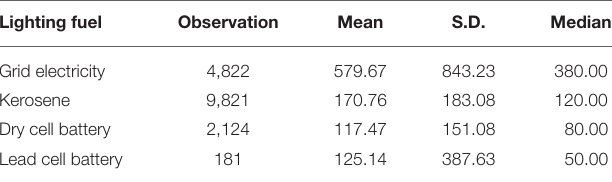
TABLE 3 | Average marginal effects of household lighting fuel choice (Full